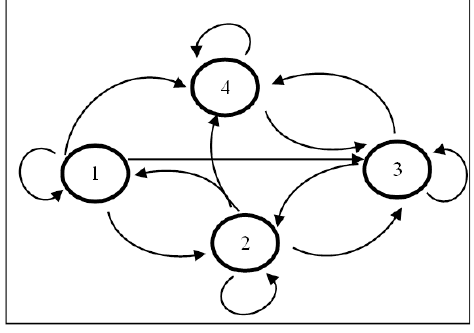
Figure 1. State transition diagram of the adaptive algorithm.